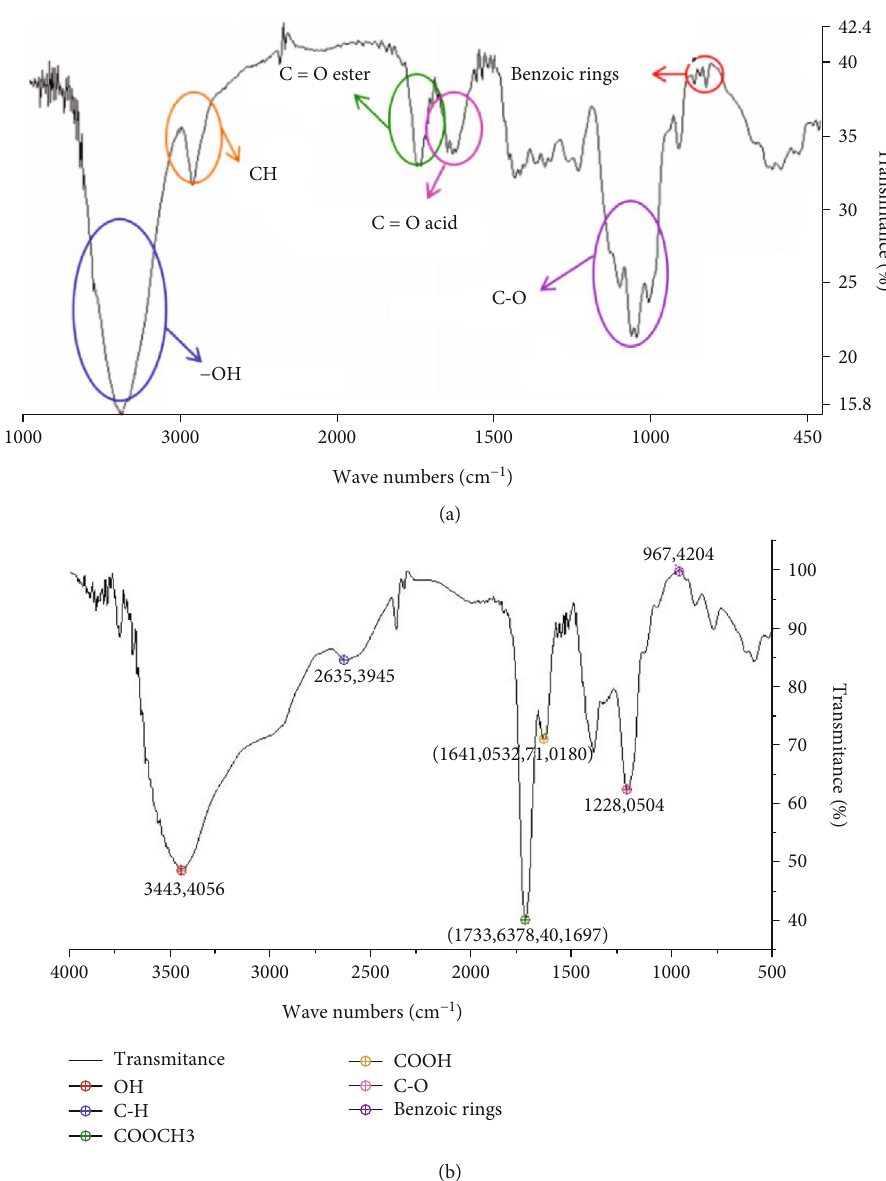
Figure 2: FTIR spectra of pectin: (a) commercial rapid-set pectin and (b) extracted pectin from watermelon